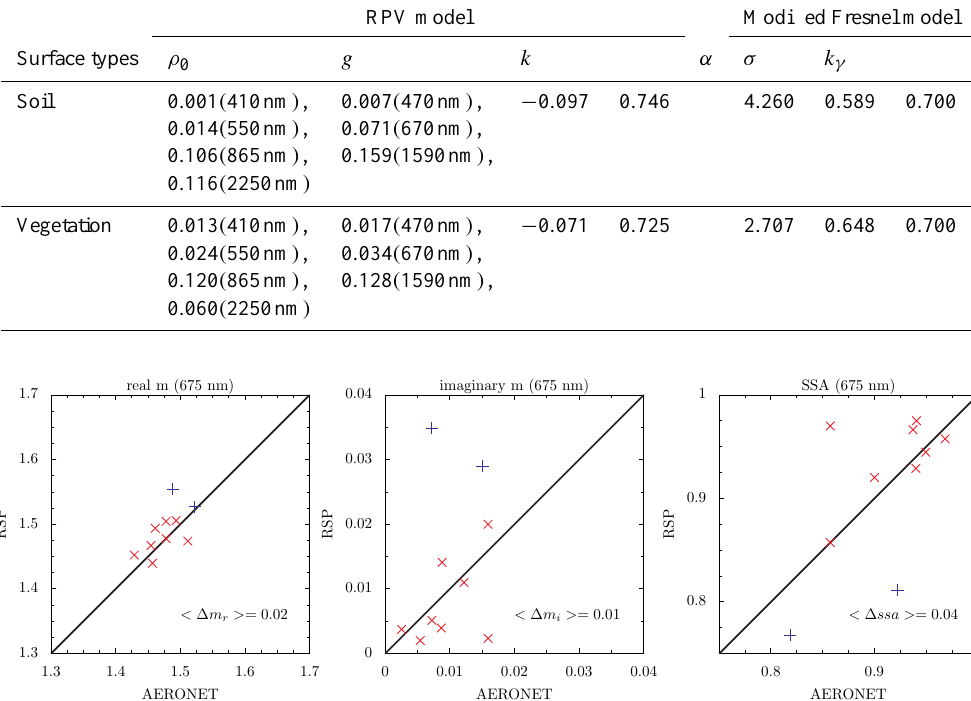
Figure 9. Comparison between retrieved single scattering albedo (SSA) and composed refractive index of RSP measurements and those provided by AERONET at 675nm. (cid:104) (cid:49) ssa (cid:105) , (cid:104) (cid:49)m r (cid:105) and (cid:104) (cid:49)m i (cid:105) are the mean absolute difference of SSA and real and imaginary part of the refractive index between RSP and AERONET. Plus indicates cases where τ 675 < 0 . 1.